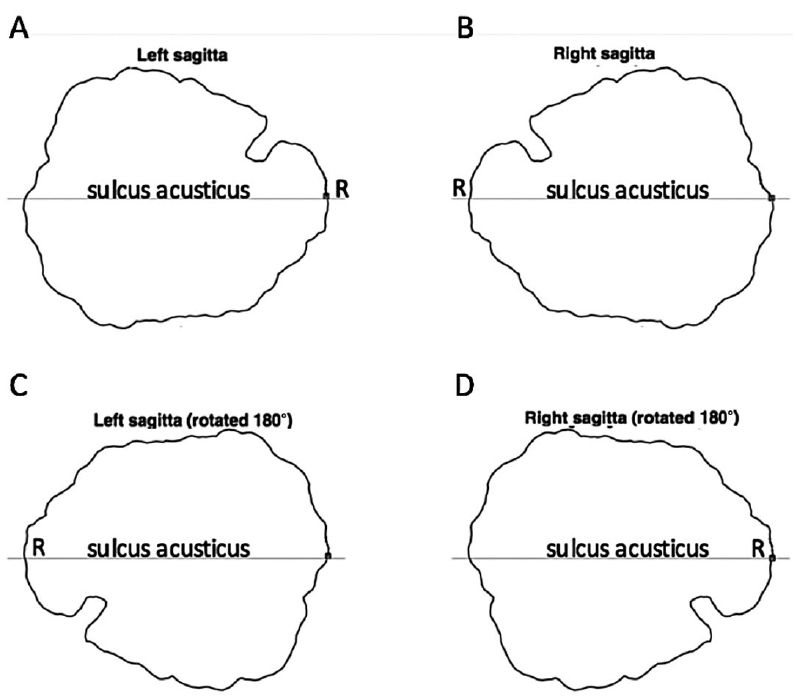
Fig. 5. – The contour of A, the left sagitta obtained following the AFORO positional normalization; B, the left sagitta rotated 180° with respect to the AFORO positional normalization; and C, the right sagitta showing the sulcus acusticus visible. This silhouette is a mirror reflection of that in A, concerning point R, and it is related to the left sagitta silhouette obtained by hiding the face of the sulcus acusticus and keeping the rostrum on the left side of the image. D, the right sagitta rotated by 180° with respect to the shape in C is related to the shape of the left sagitta contour in B, which was obtained by hiding the face of the sulcus